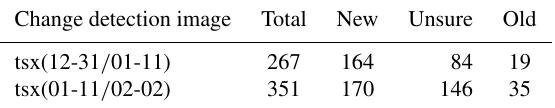
Table 2. Number and classification of manually detected avalanches in TSX images covering the first and the second avalanche periods.